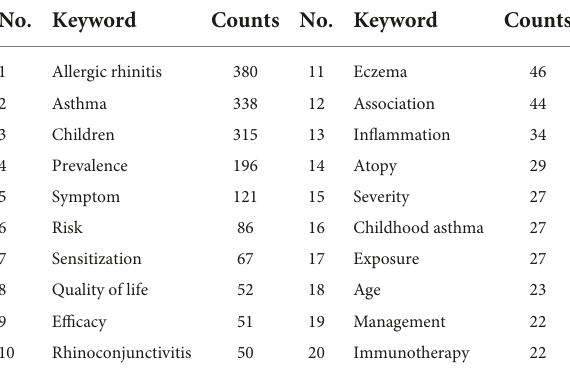
TABLE 6 Top 20 keywords in